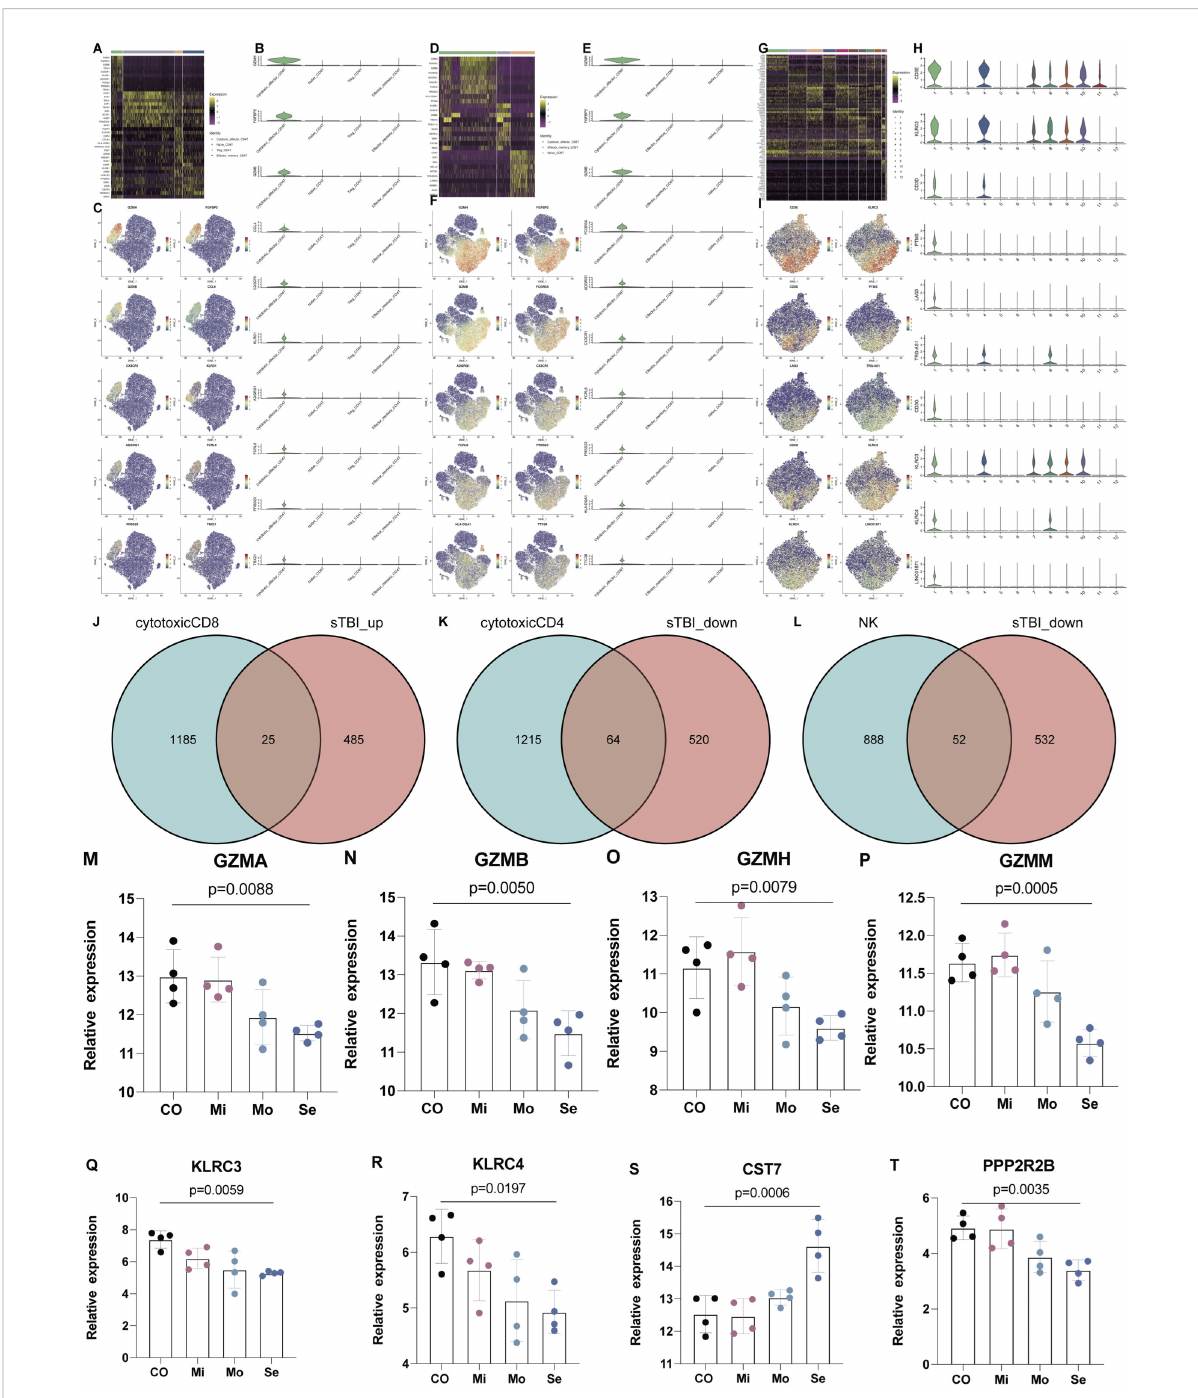
FIGURE 6 The marker genes for subtypes of CD4, CD8, and NK cells. (A) Heatmap shows the DEGs in Naïve CD4 T, Treg, Effector_memory CD4 T, and cytotoxic effector CD4 T. (B, C) Marker genes for cytotoxic effector CD4 T. (D) Heatmap shows the DEGs in Naïve CD8 T, Effector_memory CD8 T and Cytotoxic effector CD8 T. (E, F) Marker genes for cytotoxic effector CD8 T. (G) Heatmap shows the DEGs in NK cell subsets. (H, I) Marker genes for NK cell subsets. (J – L) Intersected marker genes of brain injury in cytotoxic CD8+, CD4+, and NK cells. (M – P) The expression of cytotoxic markers (granzyme A, B, H, M ) in peripheral blood of TBI patients. (Q, R) The expression of c-type lectin receptors in peripheral blood of TBI patients. (S) The expression of CST7 as a marker of cytotoxic CD8 T cells. (T) The expression of PPP2R2B as a marker of NK cells. n = 4 in each group and one-way ANOVA is